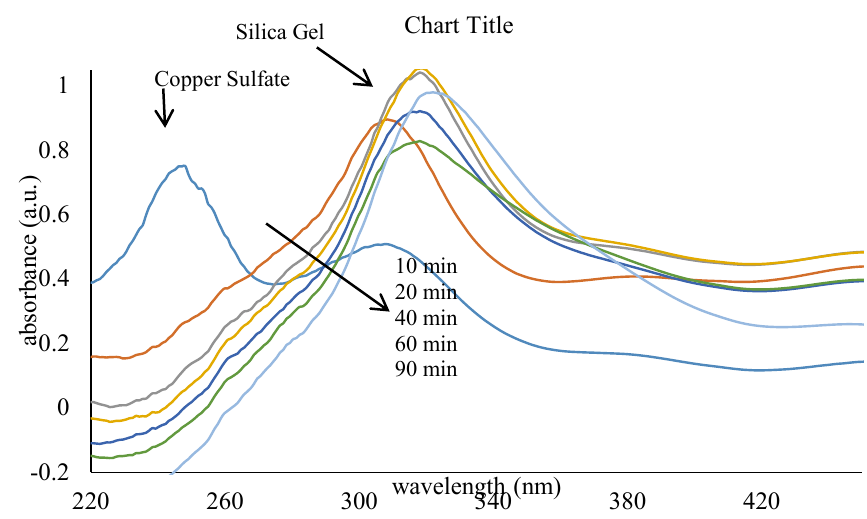
Fig. 2. The DRS graphs of the parent silica gel, copper sulfate, and the final products of CuO/SGn processing.